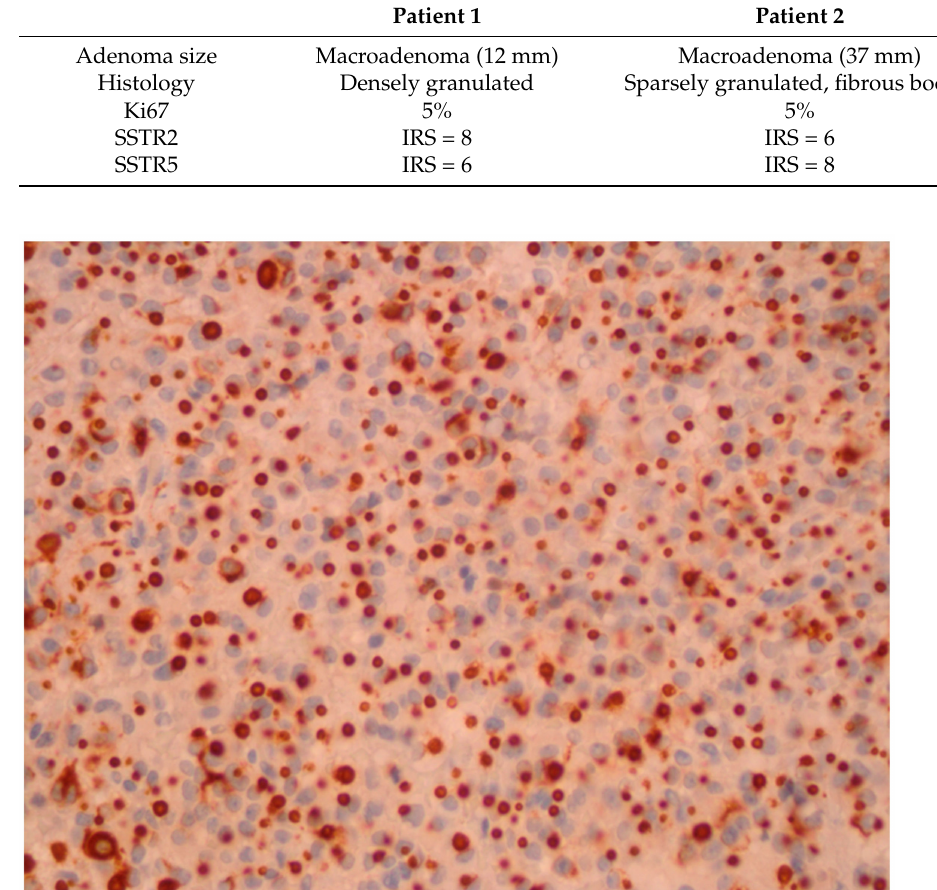
Figure 5. Abundant fibrous bodies were present in the pituitary adenoma species (patient 2).